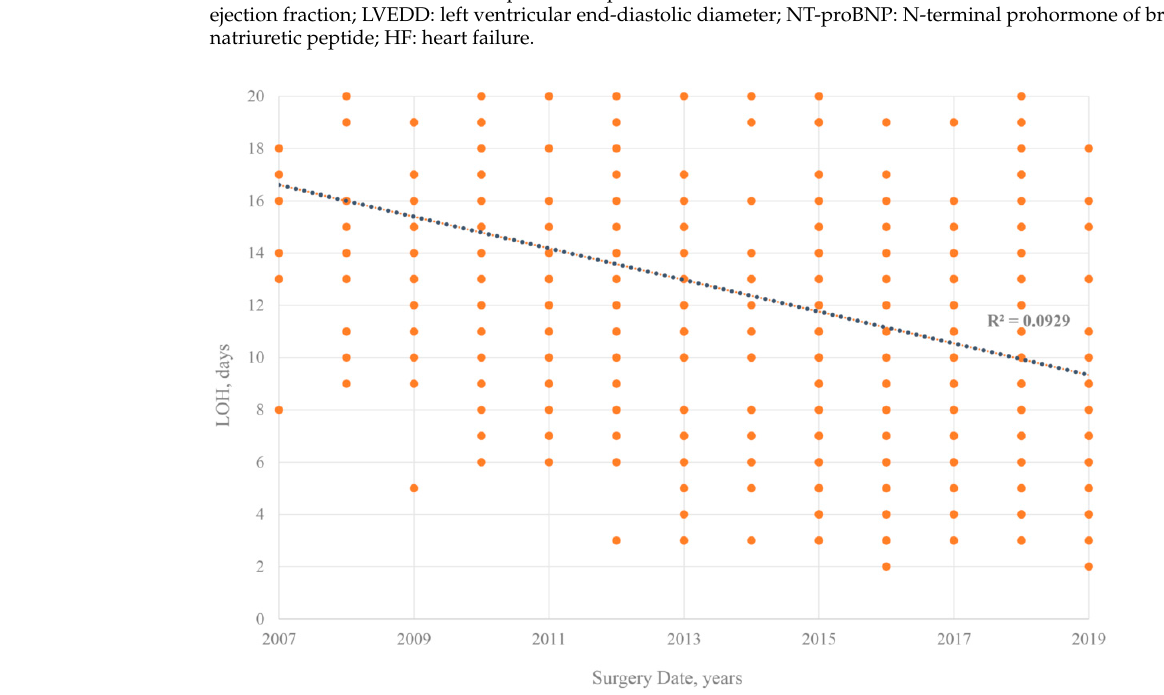
Figure 6. Changes in LOH across surgery years. Table 2. Comparison of cardiac function at follow ‐ up and outcomes between matched groups using GenMatch